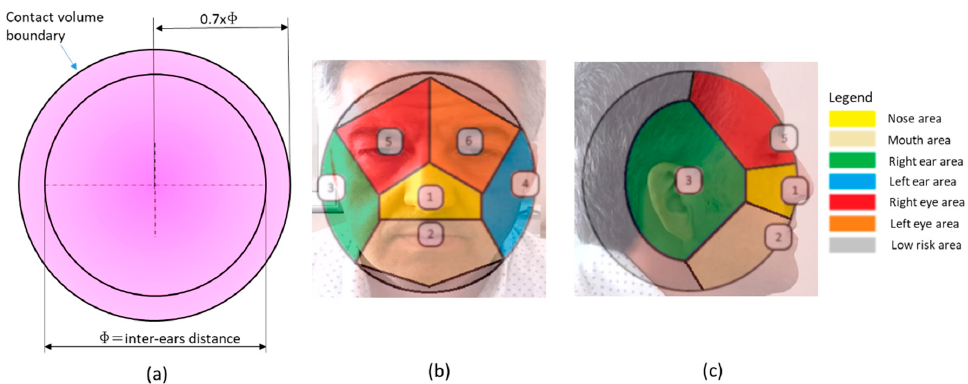
Figure 4. ( a ) The sphere modeling the head and the contact volume (in light violet). ( b ) A schematic of the contact areas on the head modeled as a sphere and projected onto the frontal plane; each number corresponds to a joint, in detail: (1) nose, (2) mouth, (3) right ear, (4) left ear, (5) right eye, (6) left eye. ( c ) A schematic of the contact areas on the head modeled as a sphere and projected onto the sagittal